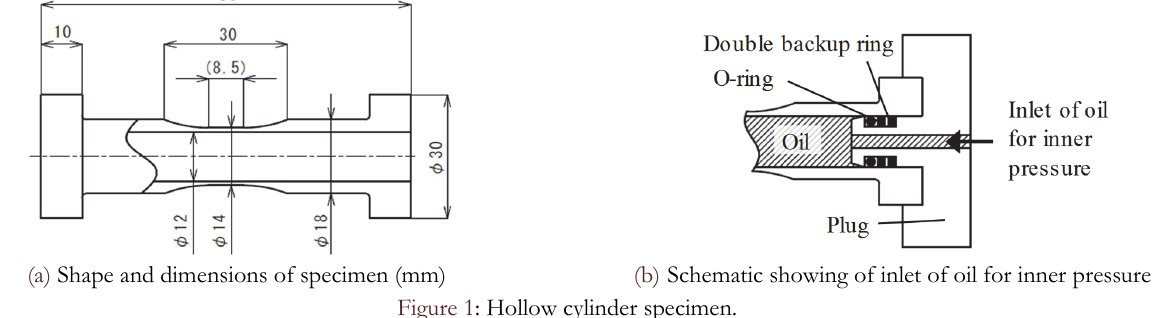
Figure 1: Hollow cylinder specimen.